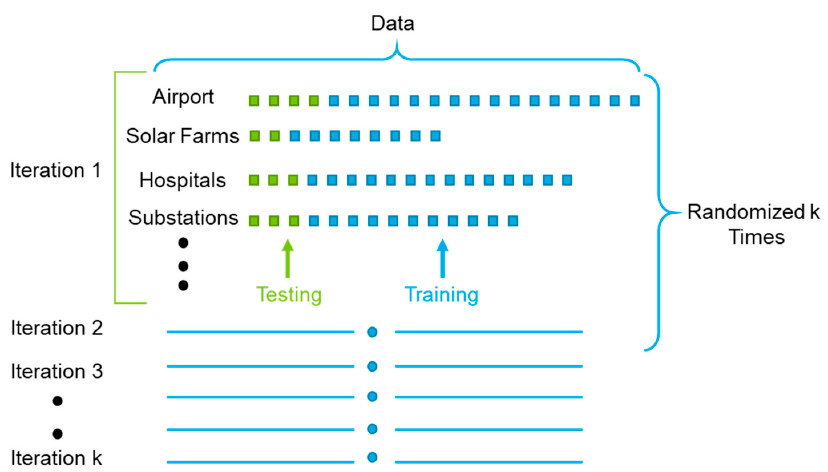
Figure 5. Visual depiction of the cross-validation process for CI dataset.